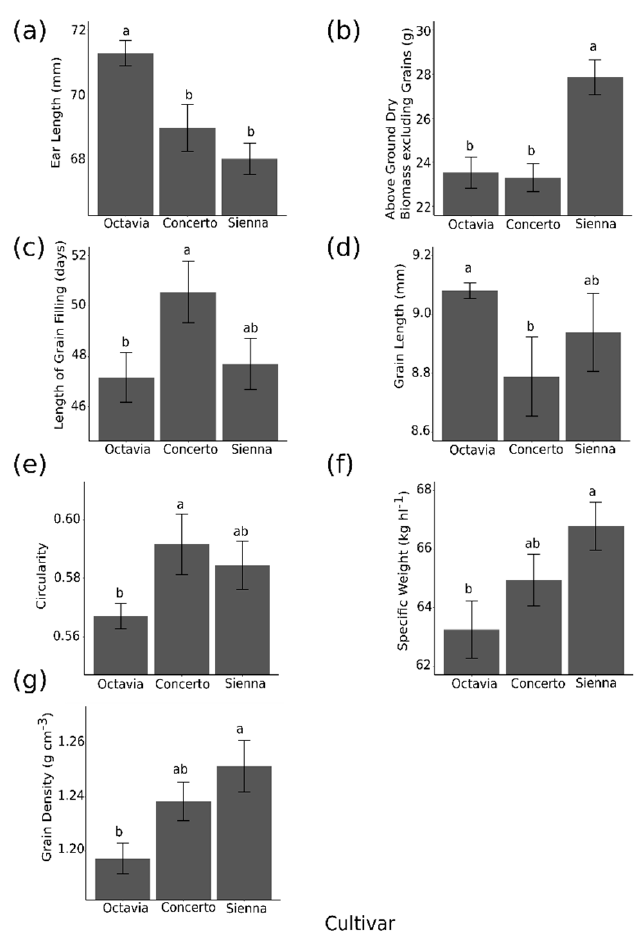
Figure 3. The significant effects of cultivar on plant growth parameters ( a ) ear length, ( b ) above ground dry biomass excluding grains, ( c ) length of grain filling and grain parameters: ( d ) grain length, ( e ) circularity, ( f ) SW and ( g ) GD. Significant differences are indicated by different letters above bars ( p < 0.05). Bars are the standard error of the means.